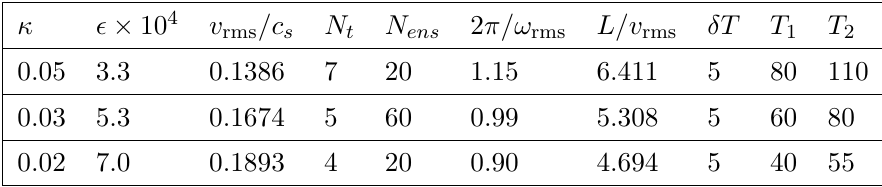
Table 1 . Parameters of inverse-cascade simulations: (cid:20) is the dissipation parameter described in (cid:10) (cid:11) section 3.3.3; (cid:15) is the growth rate of (1 = 2) T 0 i T i ; v rms =c s is the rms Mach number; N t is the 0 number of snapshots averaged over time; N ens is the number of independent runs (ensemble size); 2 (cid:25)=! rms is the eddy turnover time de(cid:12)ned by the rms vorticity; L=v rms is the eddy turnover time de(cid:12)ned by v rms and L = 2 (cid:25)= 10; (cid:14)T is the time interval between snapshots of the (cid:13)ow that are averaged over; T 1 and T 2 are respectively the (cid:12)rst the last times over which the temporal average is computed. For comparison, note that the light-crossing time is 2 (cid:25)